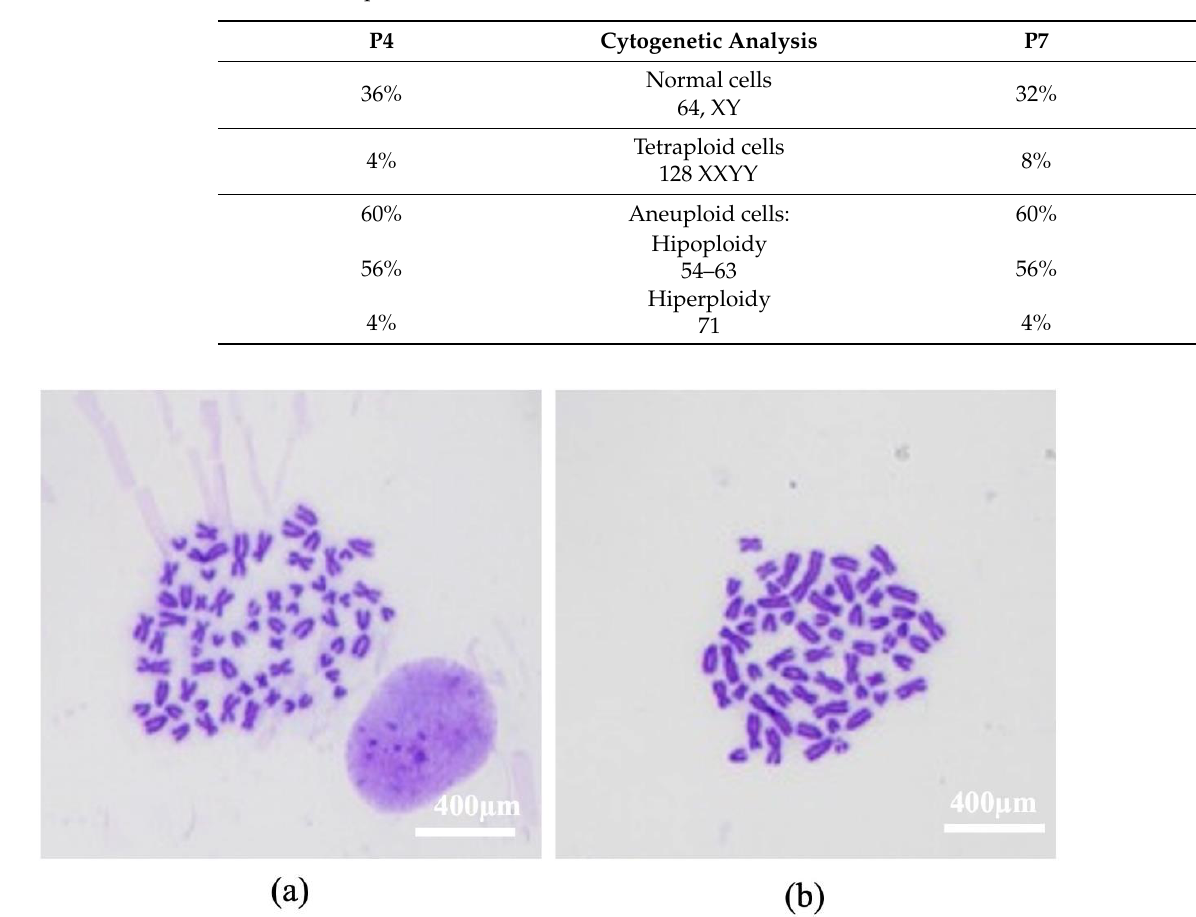
Figure 6. Karyotype. Images of eSM-MSC cytogenetic analysis Passage 7 (P7): ( a ) Normal karyotype, 64 chromosomes, XY; ( b ) hypoploid cell, 59 chromosomes, 3 acro and 2 submeta. Magnification 100 ×